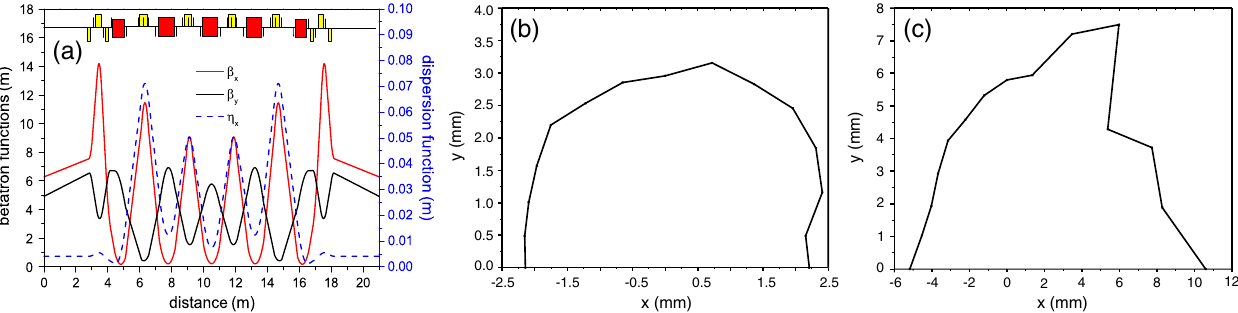
¼ 0 : 122 208 and (cid:5) ¼ 0 : 053 921 x y